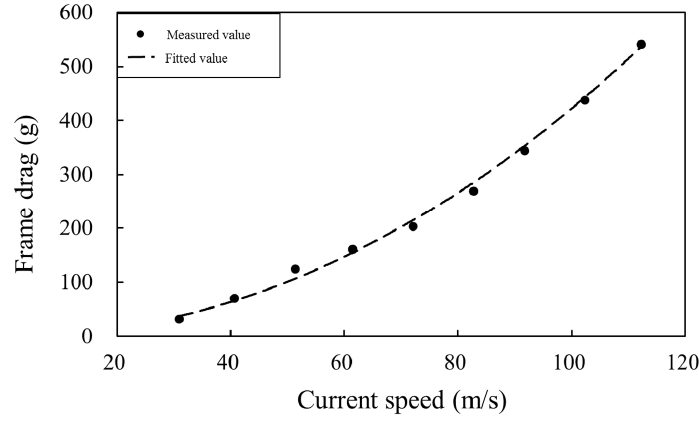
Figure 4. The relationship between frame drag and current speed.